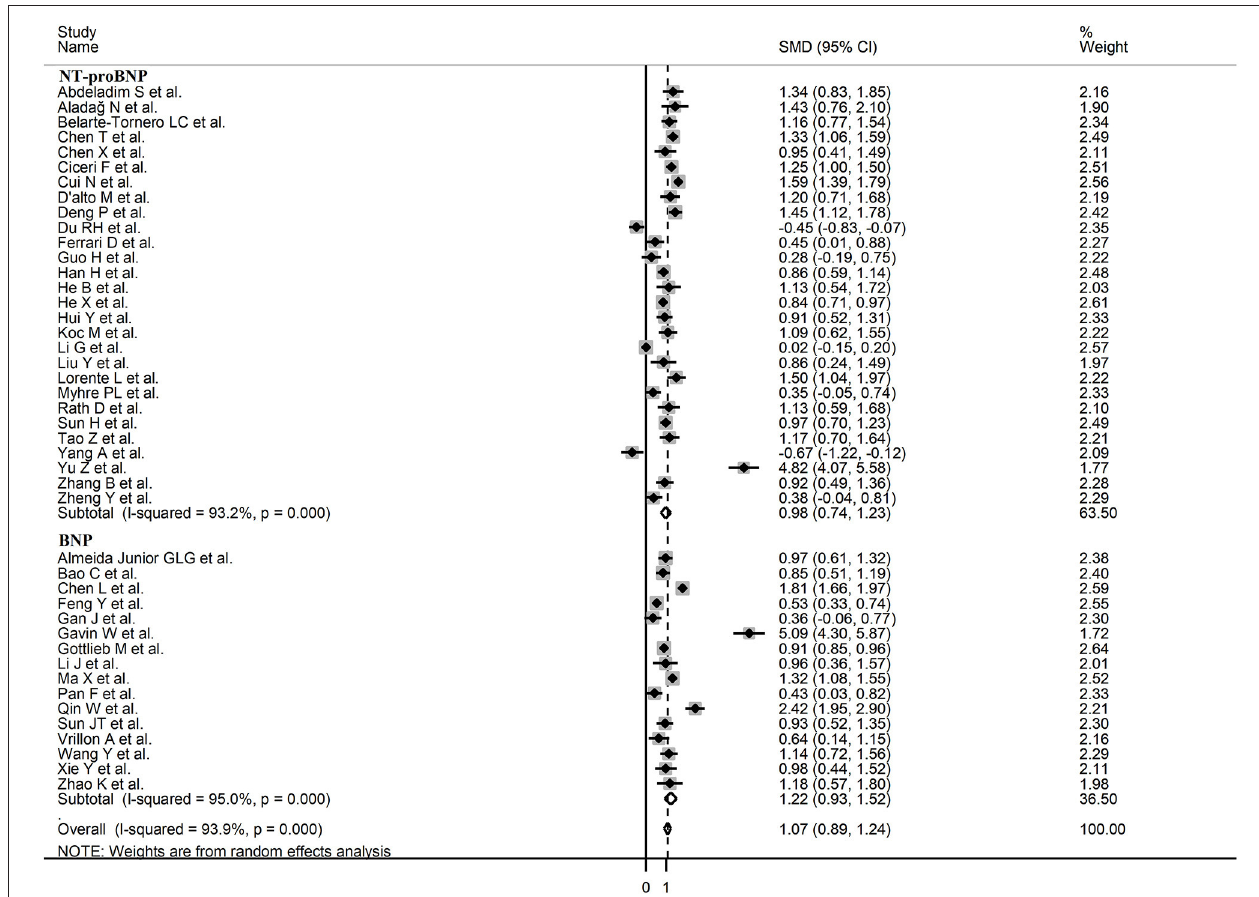
FIGURE 8 | Forest plot of studies examining BNP concentrations in patients with COVID-19 according to whether plasma NT-proBNP or BNP was